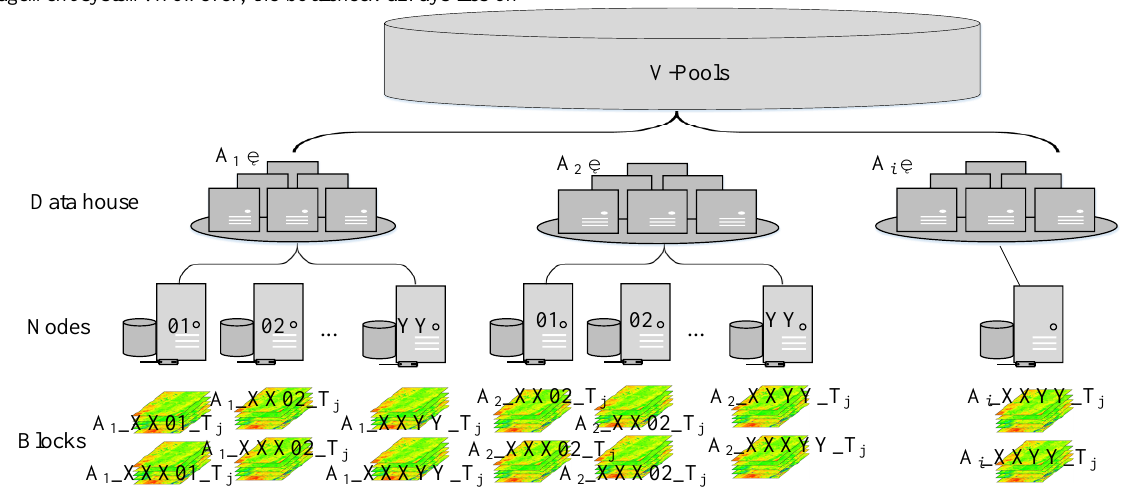
responsible for several dataset independently. The datasets are divided into blocks which are mapped into the storage nodes according to round robin